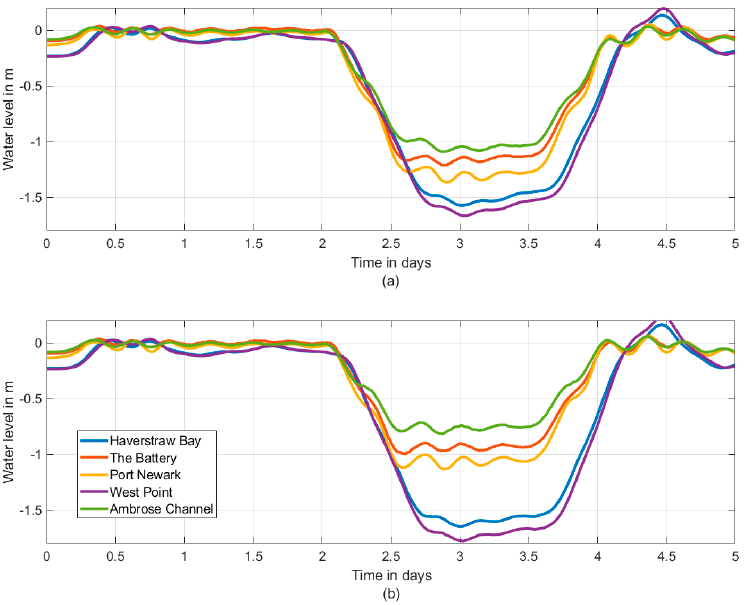
Figure 7. Modeled surge time series at several locations for ( a ) the 18 m/s west-northwest wind stress-test; and ( b ) for the 18 m/s northwest wind stress-test. The wind directions for blowout events from composite meteorological reanalysis and Newark Airport (Figure 6) suggest that Northwest or West-Northwest winds are optimal for negative surge at NYH, and similarly the optimal direction obtained by wind stress-testing with a constant wind forcing is West-Northwest. Any small rotational difference may be due to the historical wind data analyses being averaged at the apex of New York Bight with a variable wind forcing, whereas in the stress-test, the constant wind forcing acts over a larger scale. As isobars curve further out to sea (Figure 6a), winds correspondingly rotate counter-clockwise. The polar diagrams (Figure 8) from the stress-test capture the directional sensitivity of positive and negative surges and show results that gradually rotate clockwise with distance up the Hudson River. Specifically, surge at the harbor entrance (Ambrose channel) is most sensitive to East/West directed winds, whereas up-river locations (e.g., West Point) are most sensitive to Northwesterly/Southeasterly winds. To examine how local harbor/estuary wind forcing relates to surge response, we define “fetch direction” as the direction of maximum fetch at a particular location in the harbor; at The Battery and Port Newark, fetch is aligned along a (22.5°; 202.5°) axis, at Haverstraw Bay and West Point, it is along (135°; 315°) and at Ambrose channel along (112.5°, 292.5°). Similarly, the wind directions causing strongest surges (positive and negative) are referred to as the “optimal wind directions”; at The Battery and Port Newark, the optimal wind directions are 112.5° and 292.5° for positive and negative surge, respectively. This is a rotation of 90° counter clockwise from the fetch direction. A similar counterclockwise rotation of 22.5° is observed at the Ambrose channel which is downstream of The Battery in Figure 8. However, at upstream locations like West Point and Haverstraw Bay, the optimal directions are parallel to the fetch directions. This rotation of